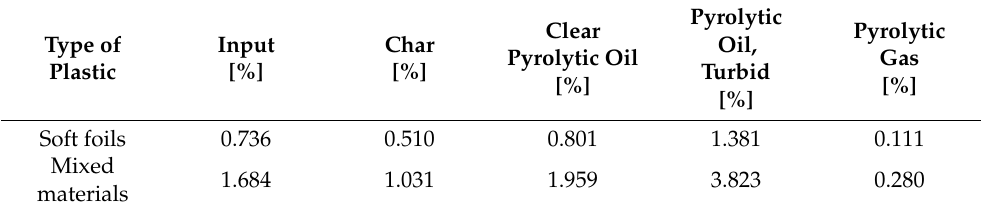
Table 3. Sulfur content of substrates and